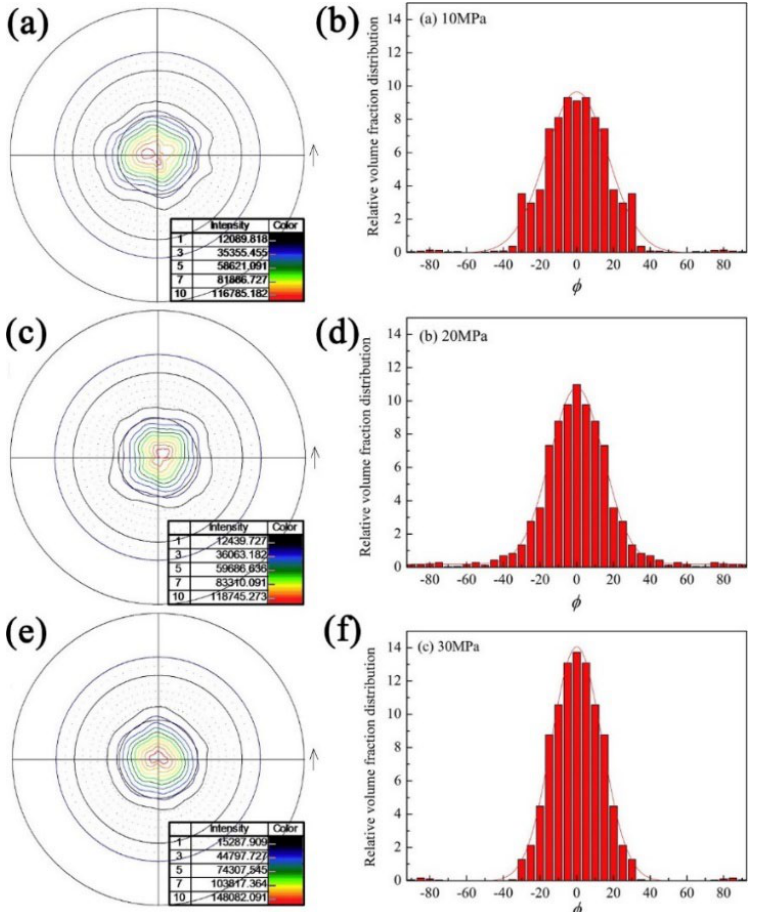
Fig. 18 (002) pole figures and relative volume fraction distribution of h-BN grains in textured h-BN matrix ceramics prepared under different sintering pressure: (a, b) 10 MPa; (c, d) 20 MPa; (e, f) 30 MPa. Reproduced with permission from Ref. [1], © Acta Materialia Inc. 2012.